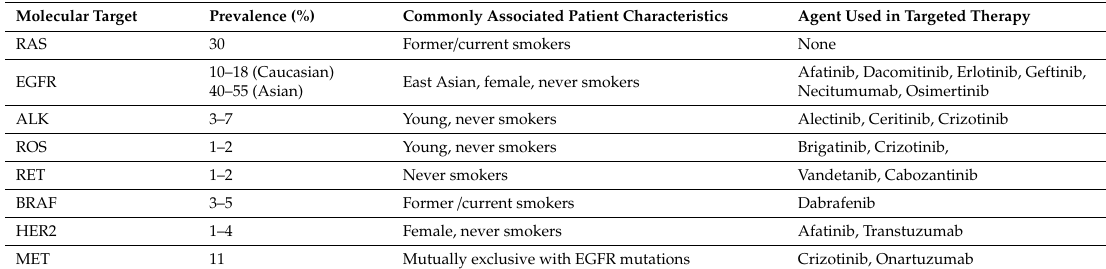
Table1. Moleculartargetsinnon-smallcelllungcancer(NSCLC),theirprevalence, patientcharacteristics and the targeted therapies applied (FDA approved). Adapted from